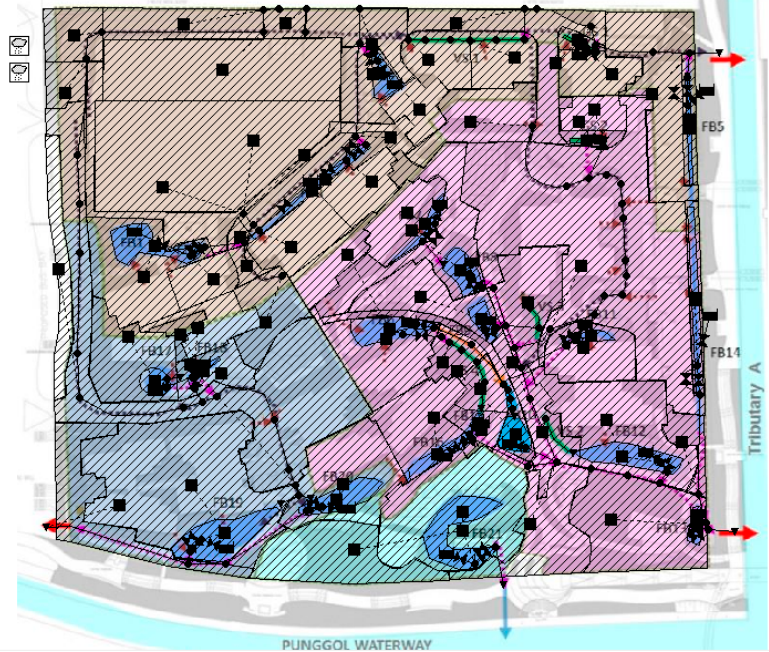
Figure 8. The completed 1D SWMM model for the precinct (in addition to the features whose colour scheme follows that of Figure 2, the other four colours depict the four main subcatchments in the precinct).